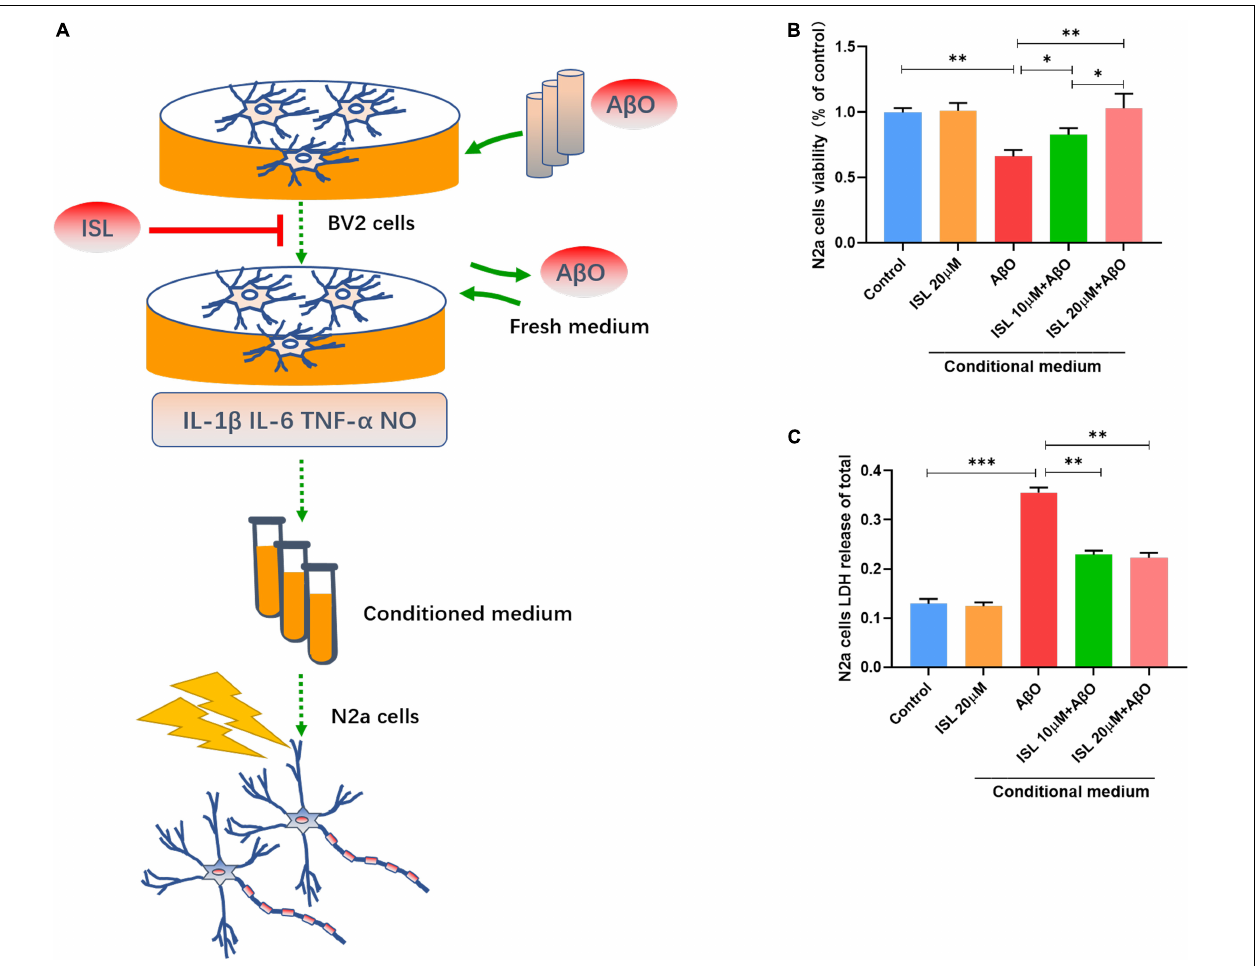
FIGURE 5 | Neuroprotective effects of ISL on N2a cells cultured with conditioned medium from A β O stimulated BV2 cells. (A) A diagram of the toxic effect of conditioned media from A β O stimulated BV2 cells on N2a cells with or without the ISL pre-treatment. (B,C) N2a cells were treated with conditioned medium for 24 h and cell viability was assessed using MTT and LDH cytotoxicity assays. ∗ p < 0.05; ∗∗ p < 0.01, ∗ ∗ ∗ p < 0.001. n = 6 per